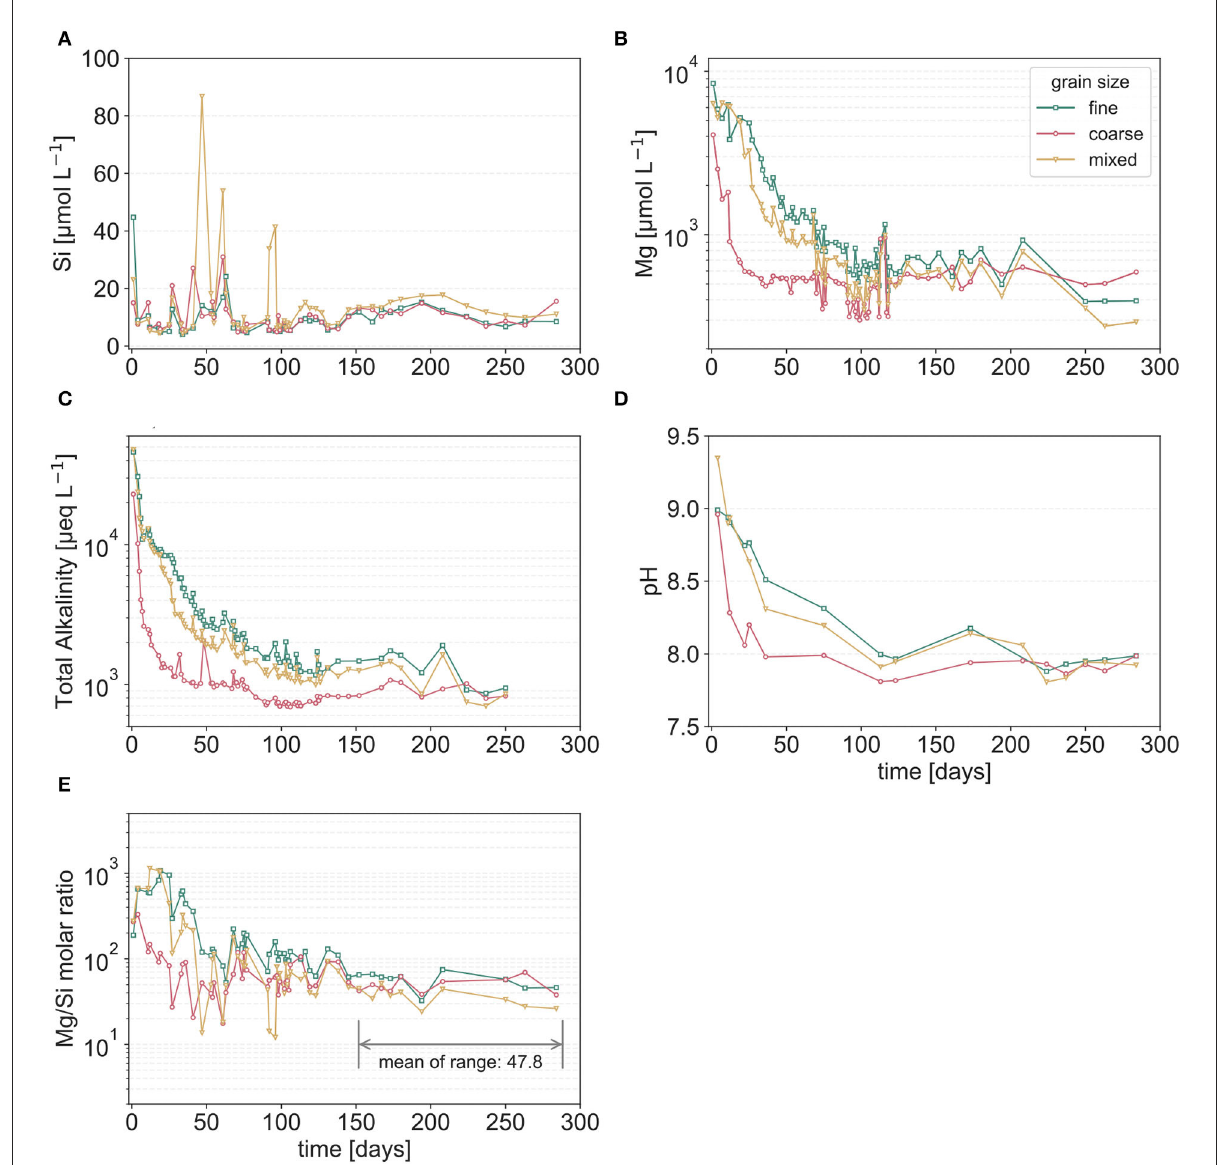
FIGURE5 Temporal evolution of averaged dissolved silica [Si, (A) ], magnesium [Mg, (B) ], total alkalinity [TA, (C) ] concentrations, and pH (D) in the outflow of the columns filled with dunite of different grain size distributions under ambient CO 2 conditions. (E) Evolution of the Mg/Si molar ratio; here the y-axis minimum was chosen to represent the nominal ratio of Mg/Si in olivine, i.e., congruent dissolution (Mg 2 SiO 4 → 2:1), Note that during the final period, values are far higher than 2, indicating a non-stoichiometric alteration process. All the data are differentiated by fine (green squares), coarse (red circles), and mixed (yellow triangles) grain